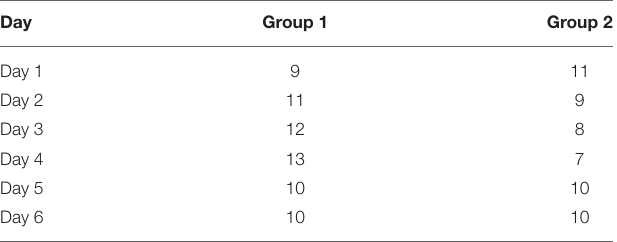
TABLE 1 | Number of selected individuals in each group during the study